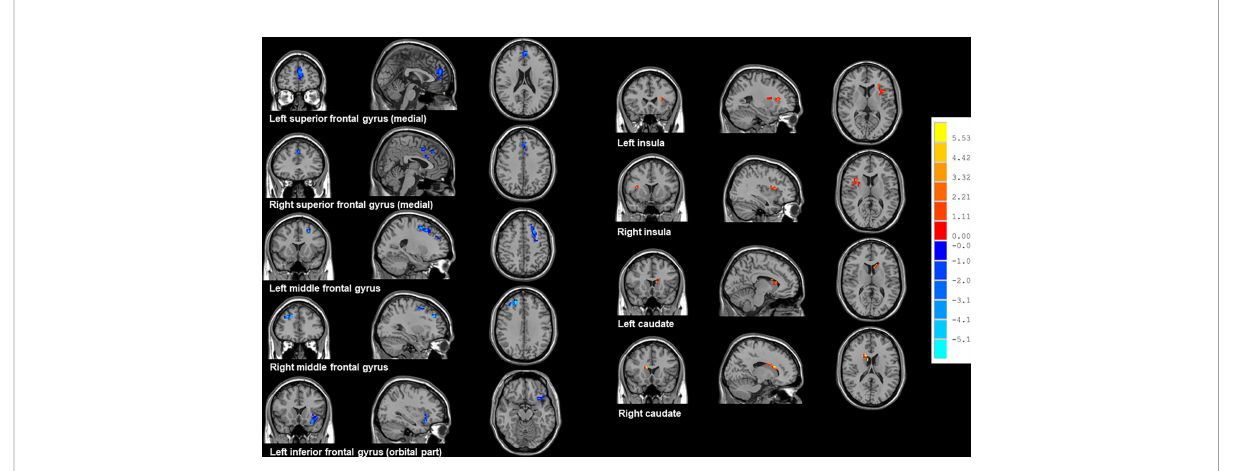
FIGURE 2 Brain regions showed altered ReHo values between all NSCLC patients and HCs. NSCLC: non-small cell lung cancer; HCs: healthy controls. ReHo: regional homogeneity. The results were obtained by two-sample t -tests. The signi fi cance threshold was set at P <0.001 at the voxel-level and P <0.05 at the cluster-level and were corrected for multiple comparisons using Gaussian Random Field (GRF) theory with a minimum cluster size of 36 voxels (two